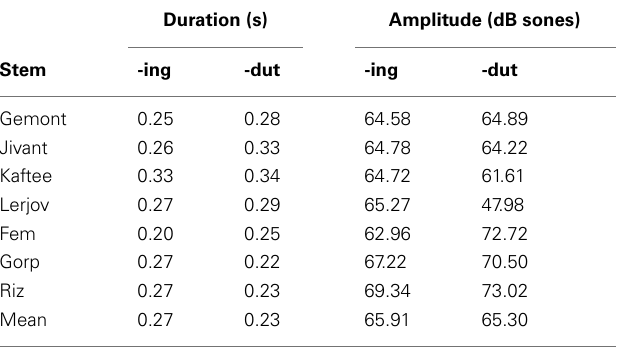
Table 5 | Duration and intensity measurements for -ing and pseudo-suffixes on target words in Experiments